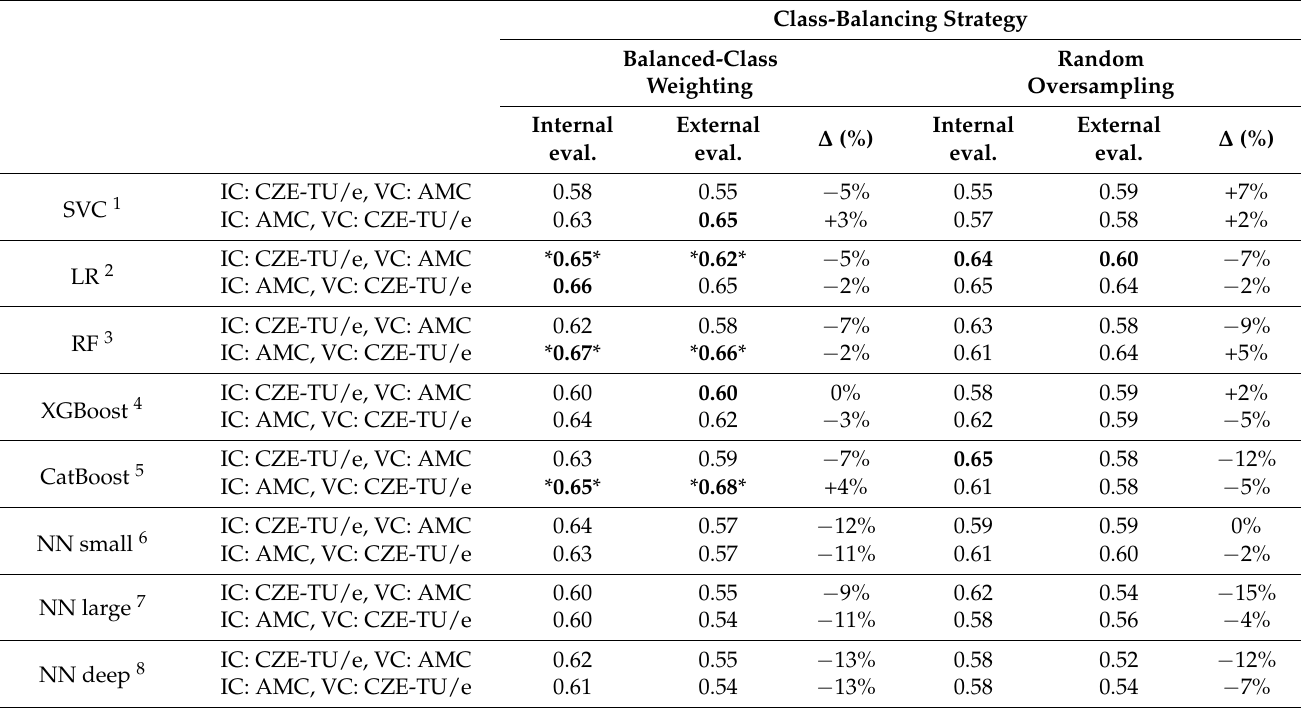
Table 1. Final evaluation, internal and external validation results comparisons based on mean AUC of the ROC curve. AUC is shown as mean and the improvement or drop in the performance of the classifier ( ∆ ) in expressed in percentage with respect to the mean AUC of the internal and of the external validation.